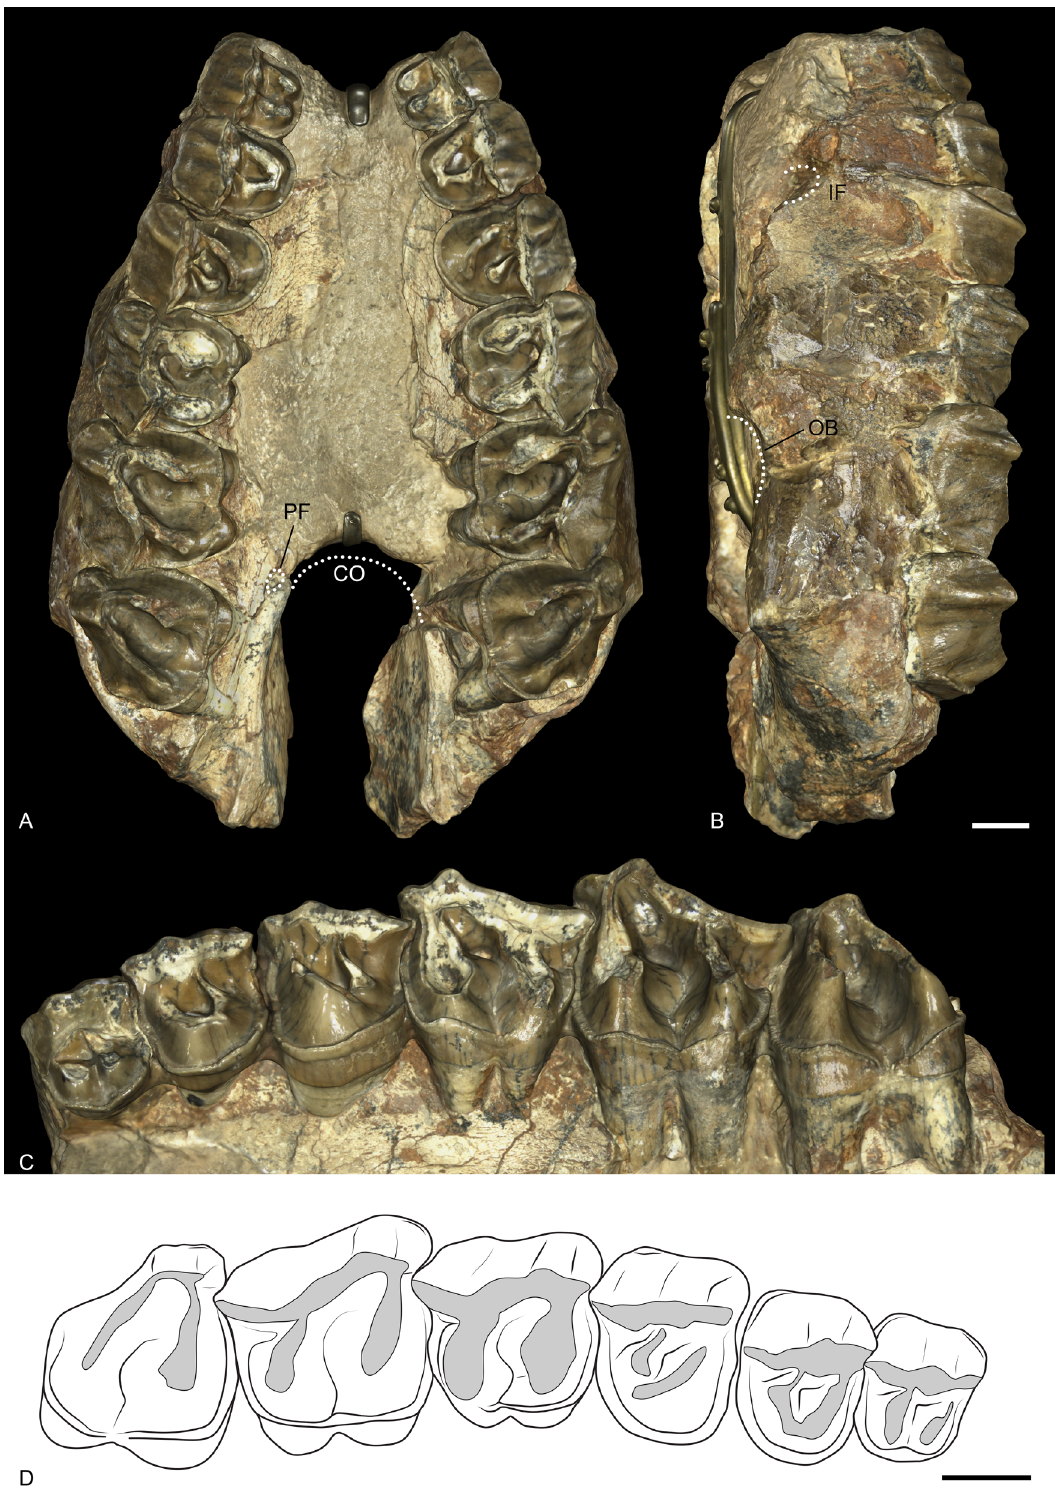
Fig. 11. Ronzotherium filholi (Osborn, 1900) from the Phosphorites du Quercy (early Oligocene?, France). Holotype maxilla MNHN.F.QU7232 with P2–M3. A . Occlusal view. B . Right lateral view. C . Left lingual view. D . Drawing of the right toothrow with P2–M3 in occlusal view. Abbreviations: CO = choanae opening; IF = infraorbital foramen; OB = orbital border; PF = palatine foramen. Scale bars: 2